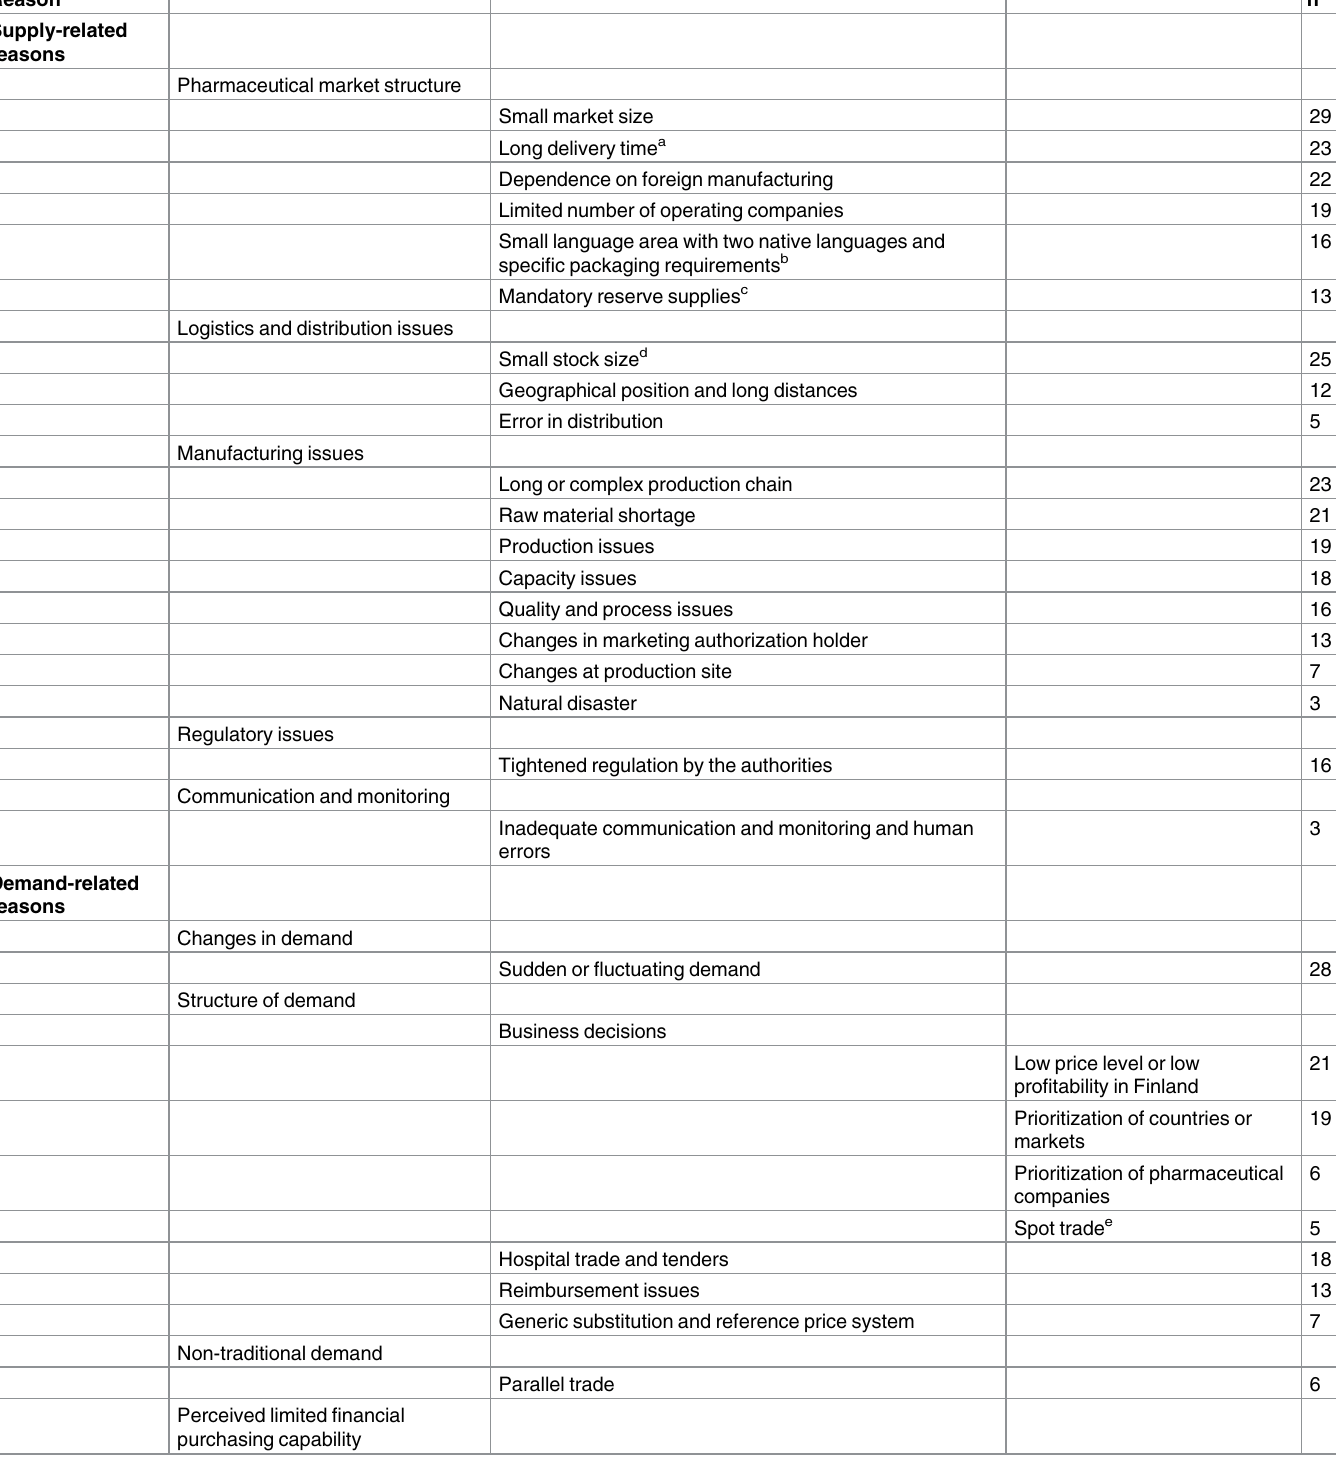
Table 3. Reasons behind medicines shortages from the perspective of pharmaceutical companies and pharmaceutical wholesalers in Finland.